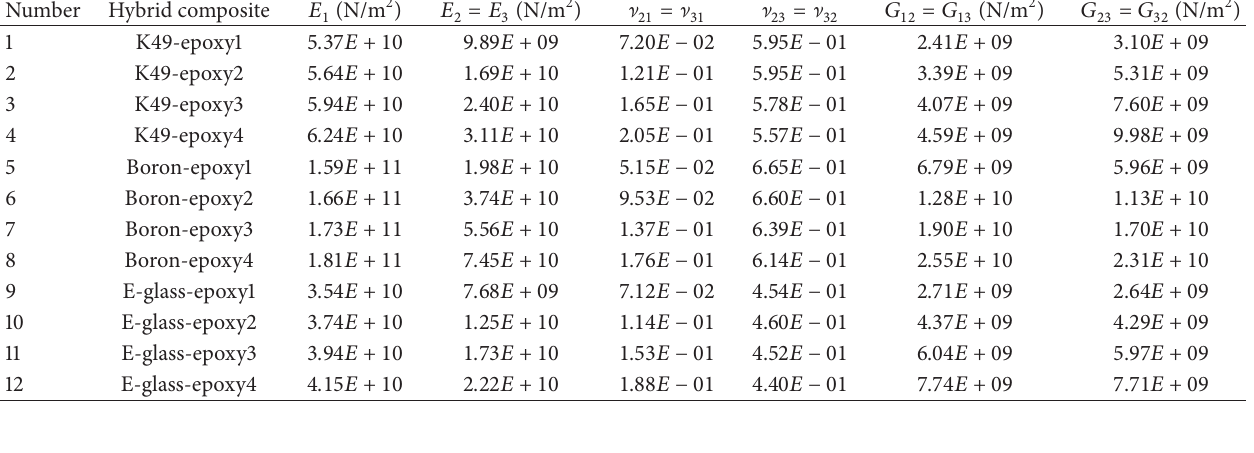
Table 1: Some of the elastic properties of some hybrid composites considered.